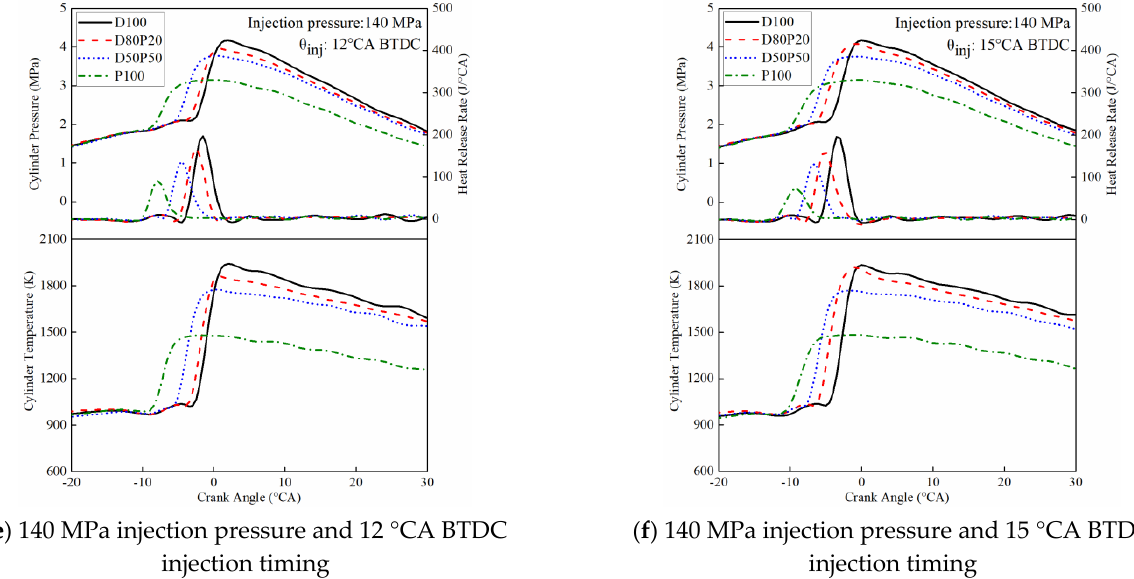
Figure 3. The cylinder pressures, HRR and cylinder temperature.